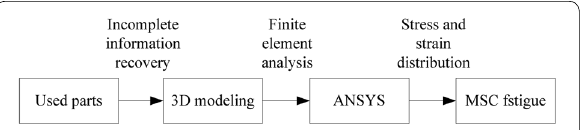
Figure 4 Life analysis process of used parts based on finite element analysis